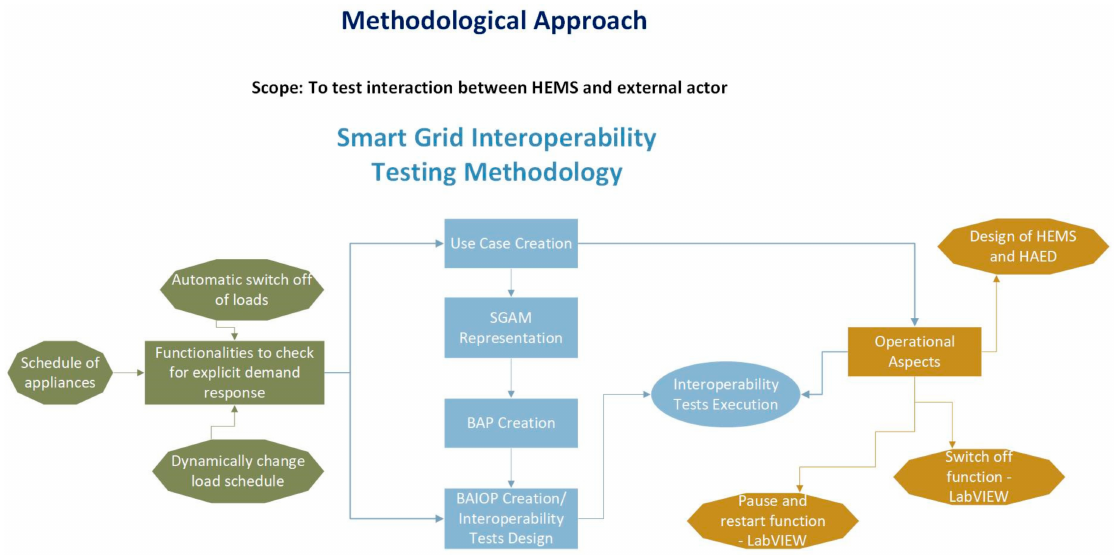
Figure 1. Methodological approach followed in this